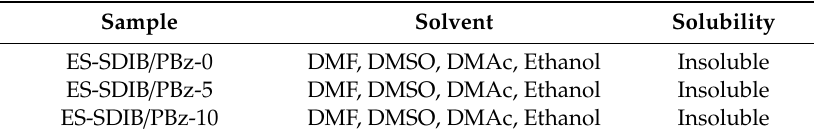
Table 2. Solubility of Electrospun SDIB / PBz Nanofibers in Common